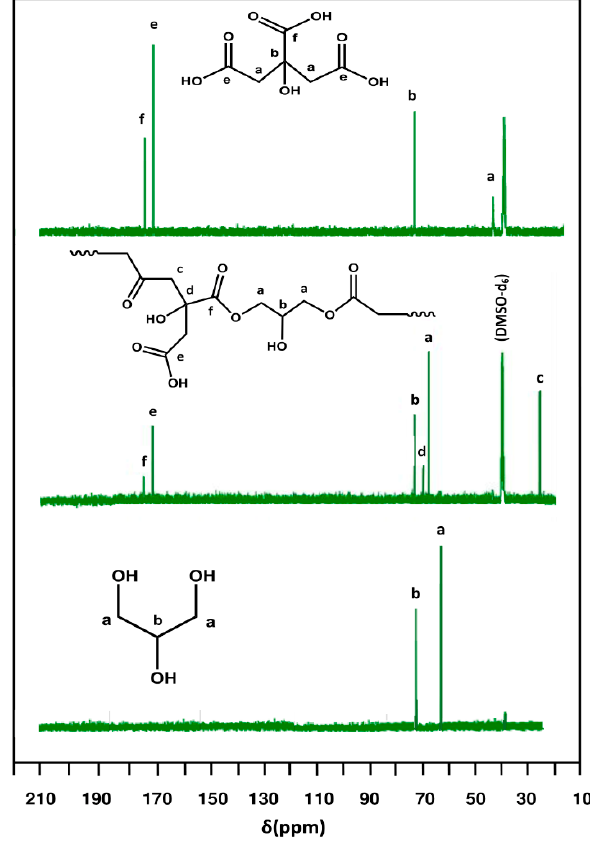
Figure 2. 13 C NMR spectra of CA and CA-co-GLC in DMSO-d6.